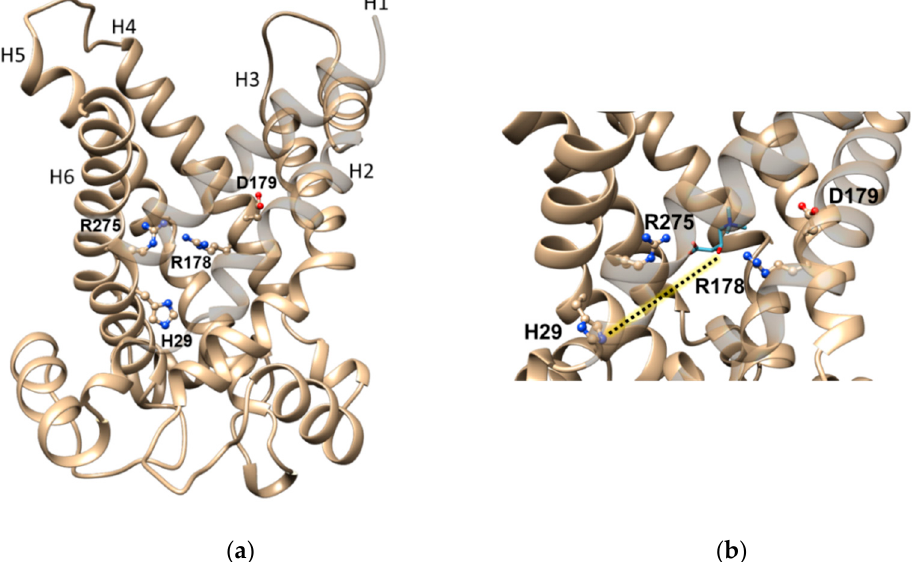
Figure 3. Ribbon diagrams of CAC showing the amino acids involved in carnitine binding. ( a ) Lateral view of the CAC structural model. The residues Arg-178, Asp-179, Arg-275, and His-29 are high- lighted with a ball and stick representation. The transmembrane spanning α -helices are numbered. ( b ) Enlarged view of the residues interacting with carnitine. The dotted line indicates the following step in the translocation process in which carnitine will interact with His-29 before the matrix gate opens (see also Figure 5). Amino acid residues are dispayed with ball and stick rappresentation in which oxygen and nitrogen atoms are depicted in red and blu respectively. CAC model and carnitine position have been obtained as [87].